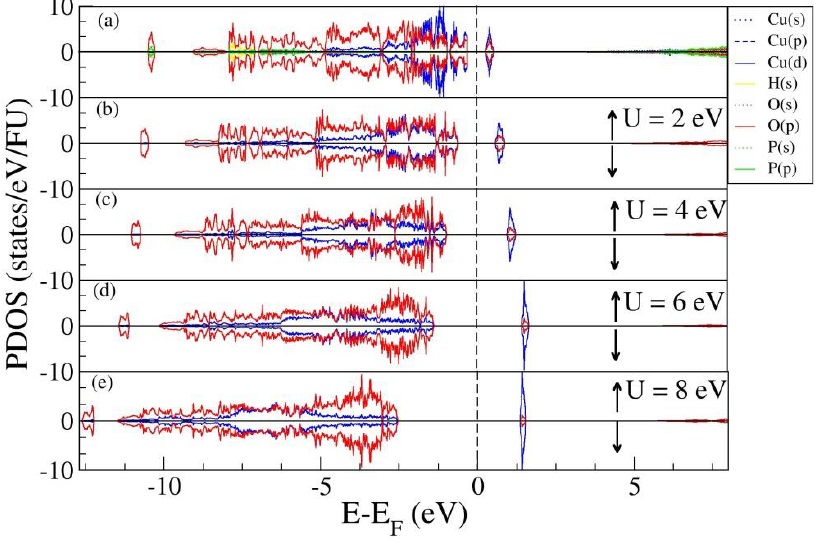
Figure 5. Partial density of states per formula unit (FU) of copper pyrophosphate using PBE and PBE+U methods in the AFM phase. The vertical dot line shows the position of the Fermi